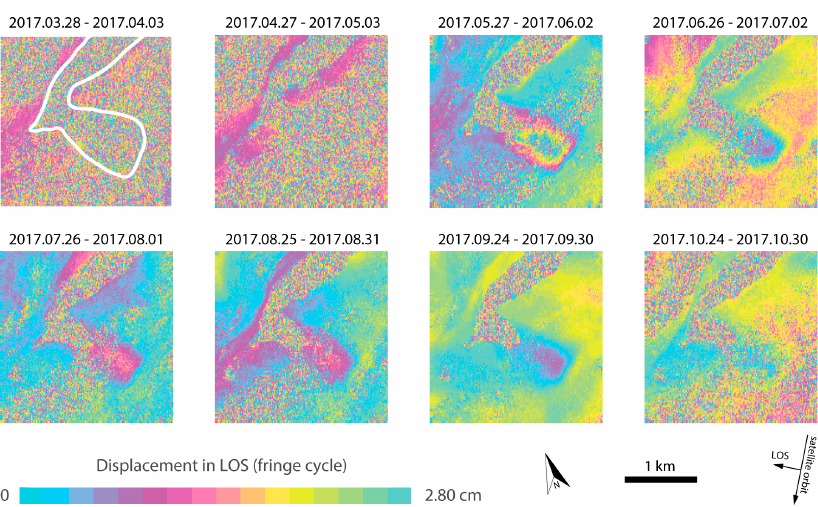
Figure 2. Selection of the Sentinel-1 (track 66, descending orbit) differential interferograms with 6-days temporal separation over the area of Moosfluh rock slope instability for the period March–October 2017. Time of acquisition for the SAR image pairs is provided in the format YYYY.MM.DD. White boundary in the upper left interferogram delineates the approximate area of the Aletsch glacier and Moosfluh slope instability (cf. Figure 1). Differential interferograms were generated by using a high resolution DEM (SwissALTI3D, 2 m GSD) and filtered [40] to increase signal-to-noise ratio. See also the Supplementary Information for the full set of differential interferograms.